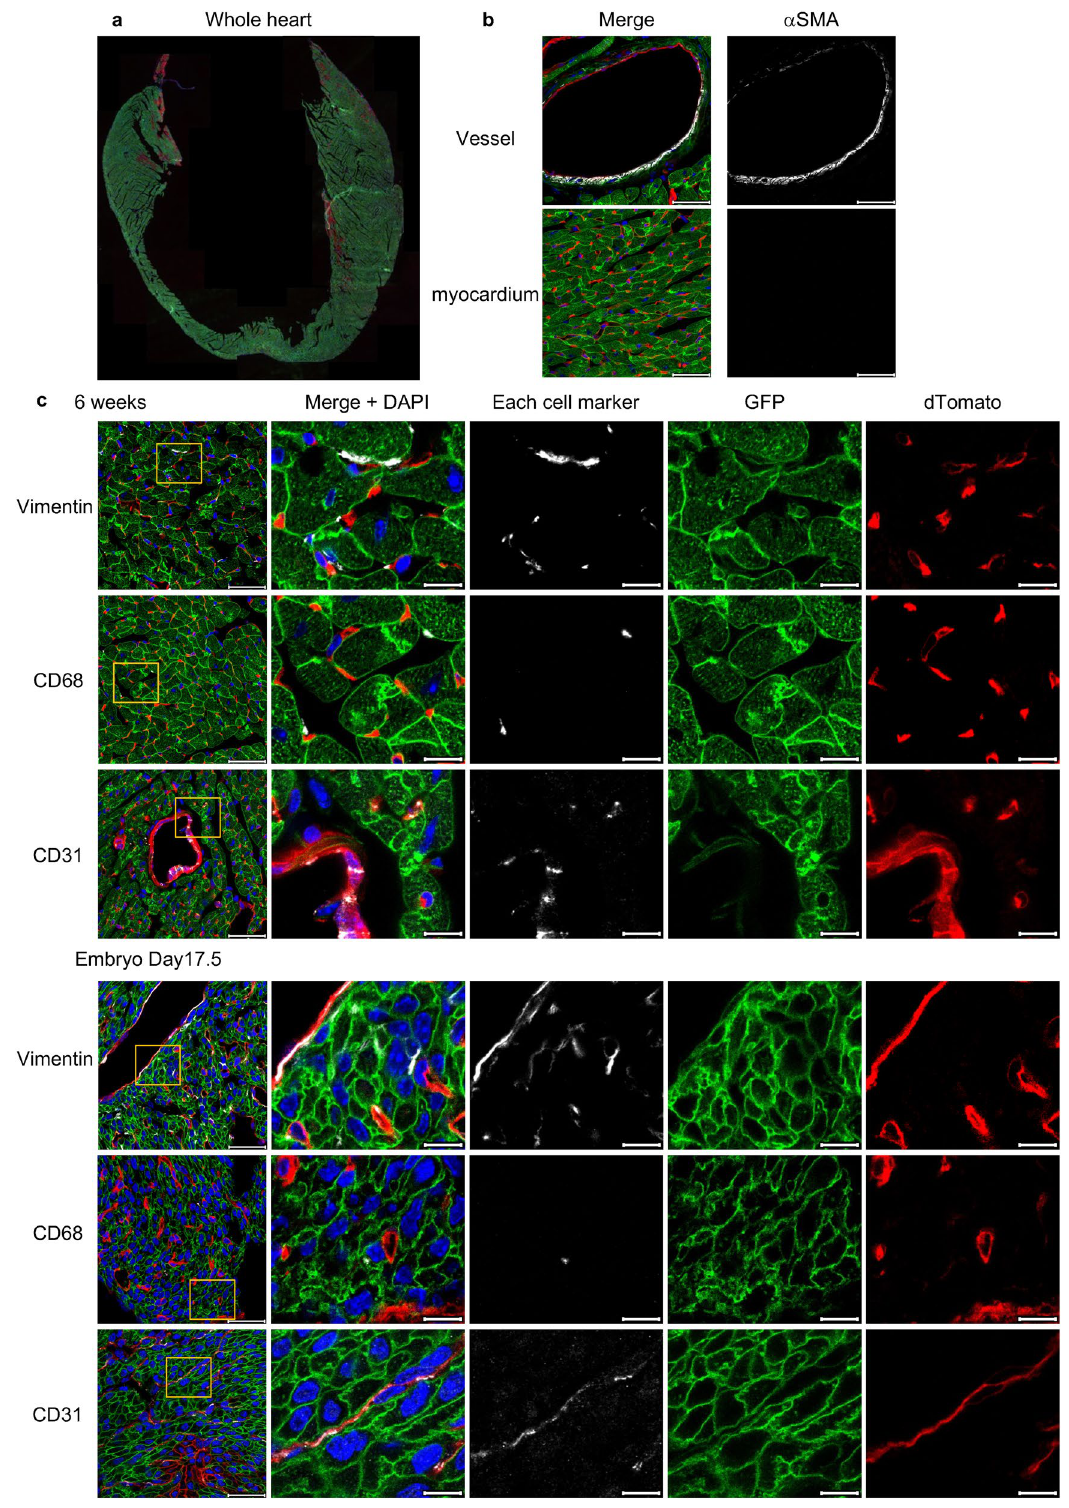
Figure 1. Immunofluorescence analysis of the hearts of SMmTmG mice. ( a ) A representative image of the whole heart without any staining. Approximately 90% of CMs expressed GFP. Original magnification: ×5. ( b ) The expression of αSMA in cardiac vessels and the myocardium. VSMCs expressed GFP. Original magnification: ×63. Scale bars: 40 μm. ( c ) The expression of the cell-specific markers, GFP and dTomato (left panels) and details (right 4 panels) in adult and embryonic hearts. There were some GFP+ CFs (Vimentin+) and GFP+ macrophages (CD68+), but no GFP+ endothelial cells (CD31+). Original magnification: × 63. Scale bars: 40 μm (original images) or 10 μm